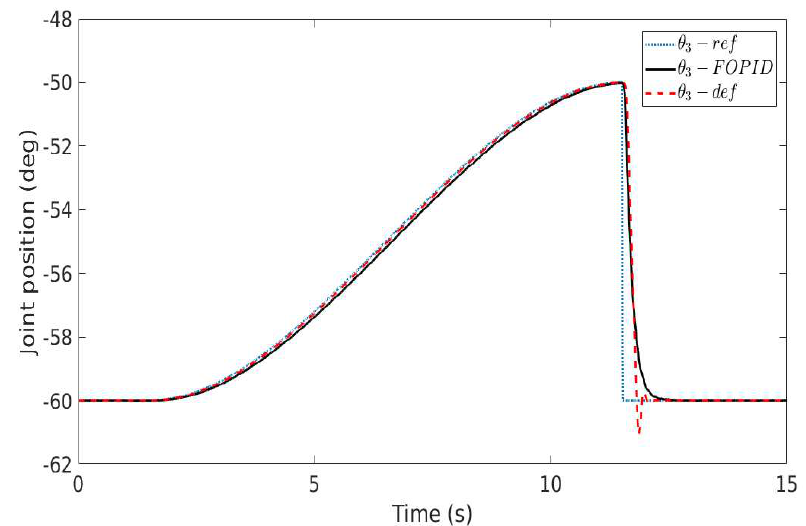
Figure 5. Step response of the UR10 robot for joint 3—the first robot configuration (ref = reference signal, FOPID = closed loop response with FO-PI controller in (23), def = default robot PID controller).